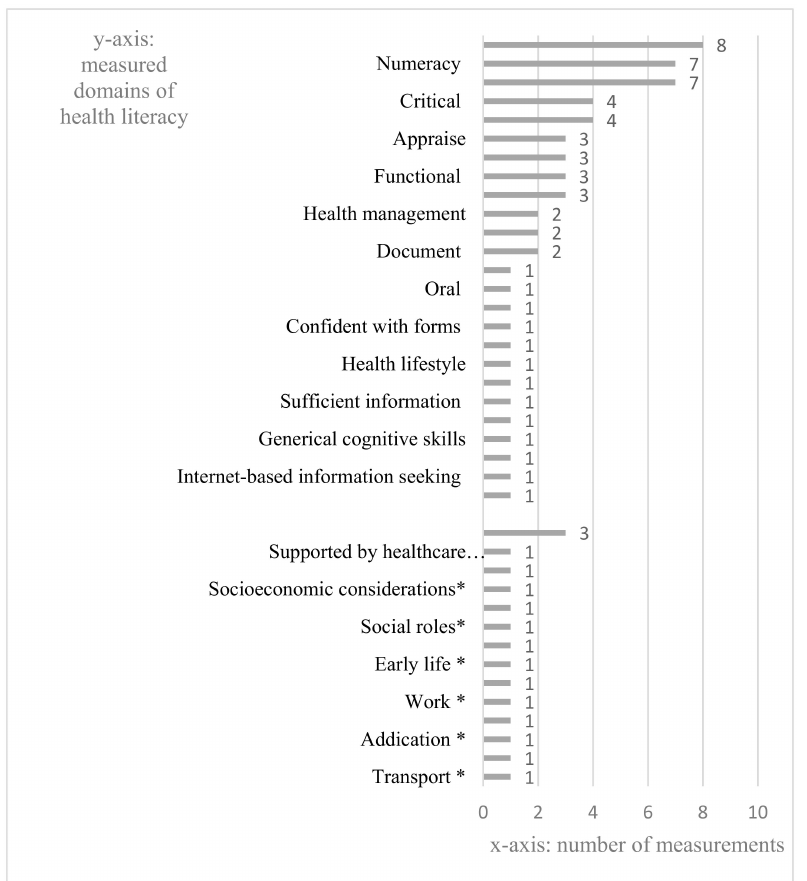
Figure 2. Measured Domains in the Identified Measurements. Notes: * = SDH-related domains; or non-SDH-related domains,